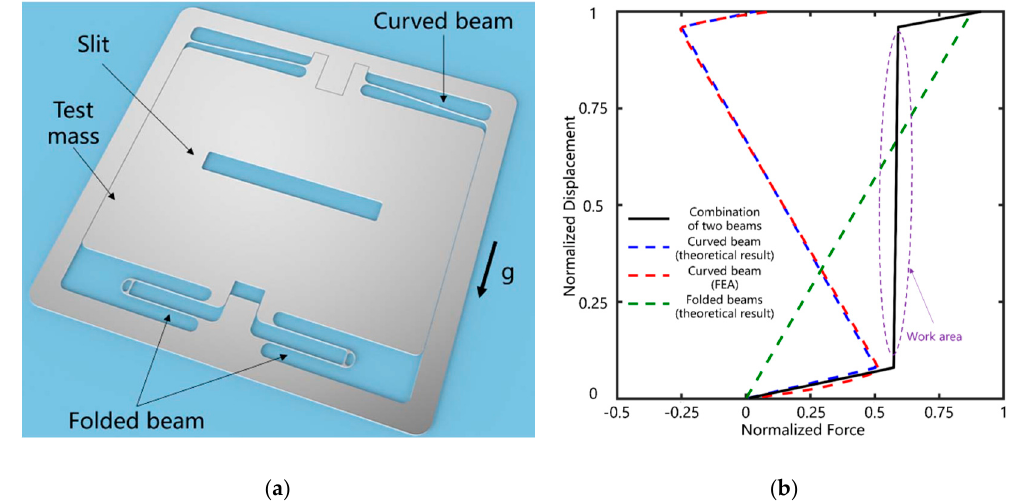
Figure 5. Schematic diagram of the MEMS accelerometer with a novel quasi-zero stiffness suspension developed by Tang et al. at Huazhong University of Science and Technology and its spring constant [23]: ( a ) schematic diagram of the MEMS mechanism; ( b ) normalized force-displacement curve of different spring designs.